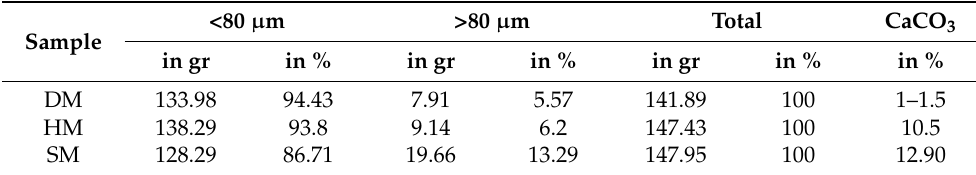
Table 1. Granulometric analysis by sieving and carbonate test results.